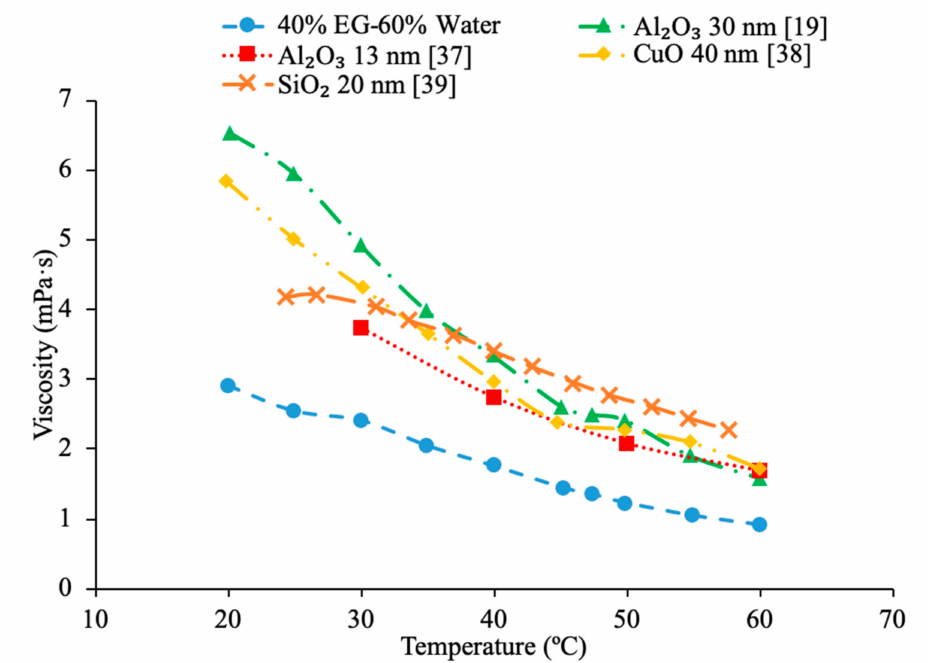
Figure 10. Viscosity of CuO, Al 2 O 3 , and SiO 2 nanofluids with 40% ethylene glycol (EG) and 60% water as a base liquid as a function of temperature with various sized nanoparticles of 13, 20, 30 and 40 nm